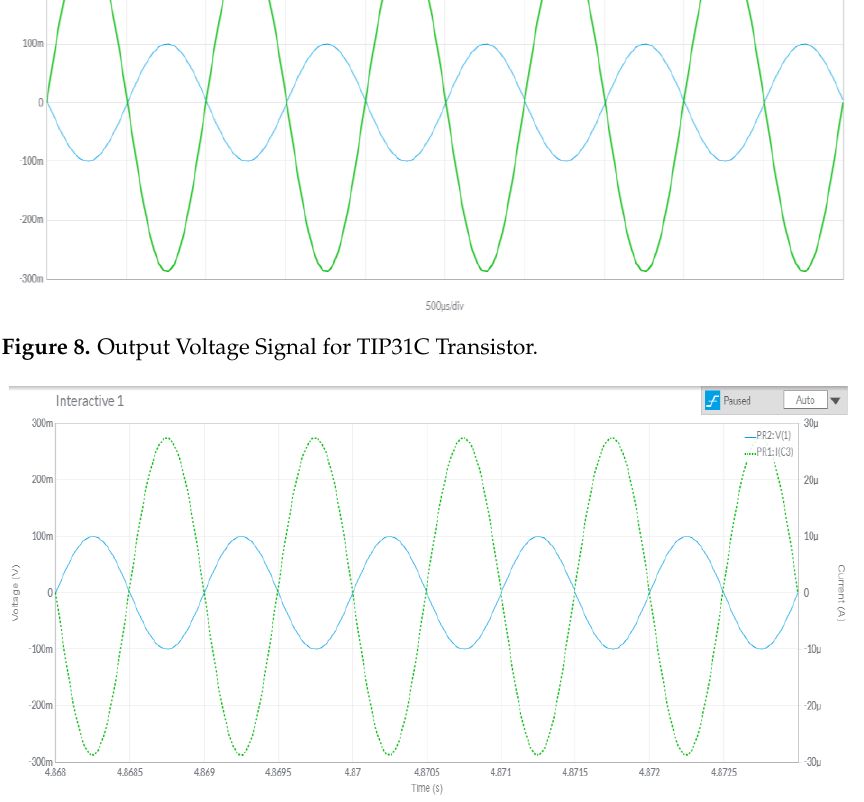
Figure 9. Output Current Signal for TIP31C Transistor.